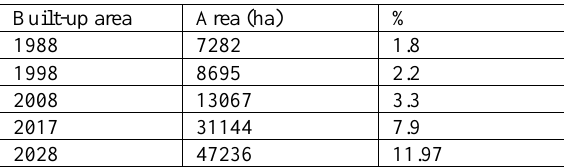
Table 3. Built-up area changes detection and prediction